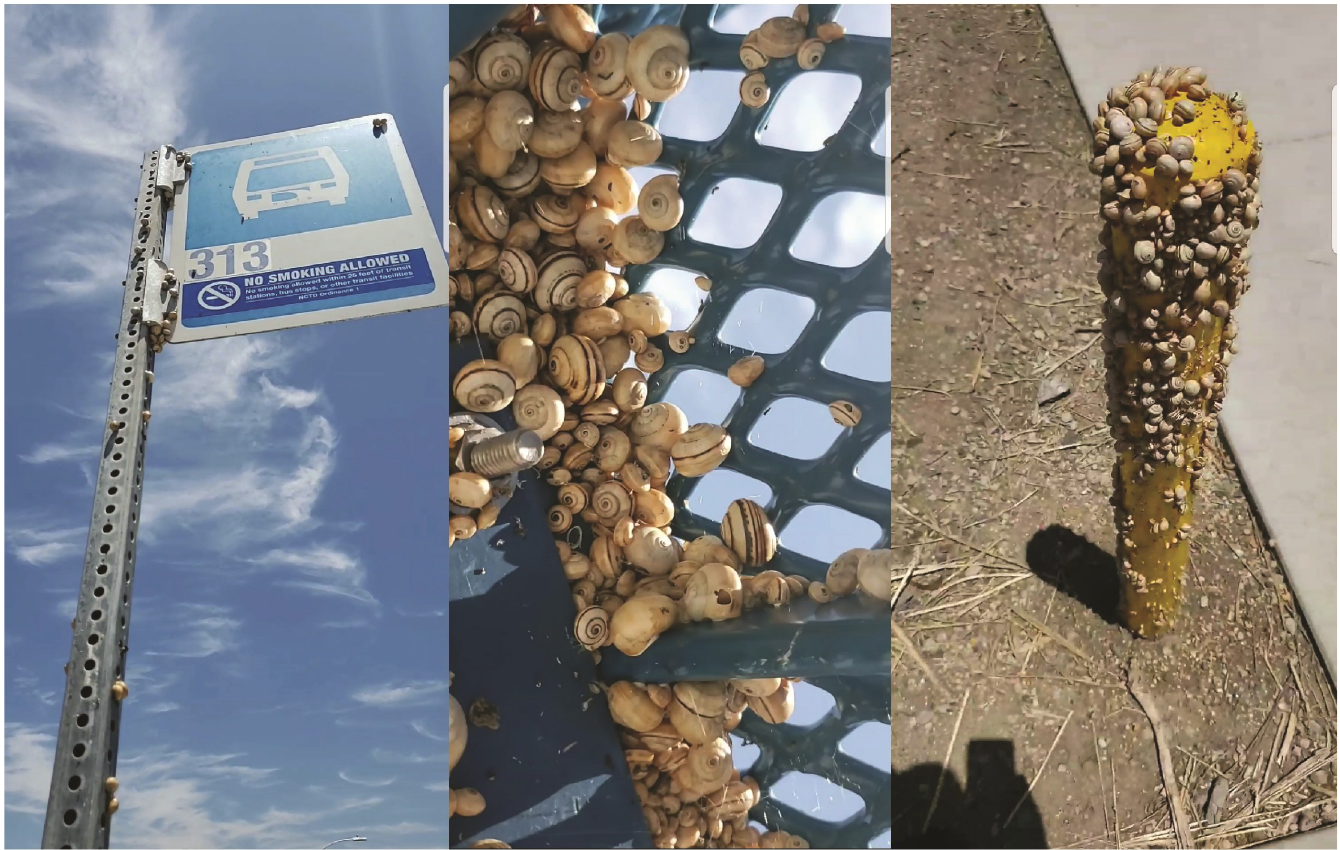
Fig 1. Left to right: Theba pisana aestivating on a bus stop sign; beneath a bus stop steel bench and on a yellow pole near a sidewalk in Oceanside, CA.